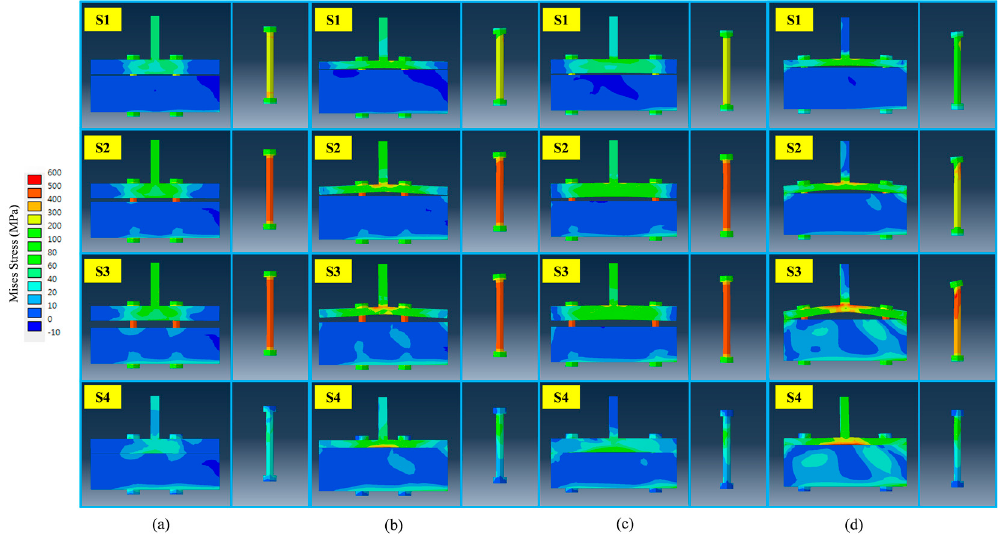
Figure 12. Von Mises stress contours and deformation configurations (DSF = 5.0; DSF: Deformation scale factor): ( a ) Case-3; ( b ) Case-7; ( c ) Case-11; ( d ) Case-15.